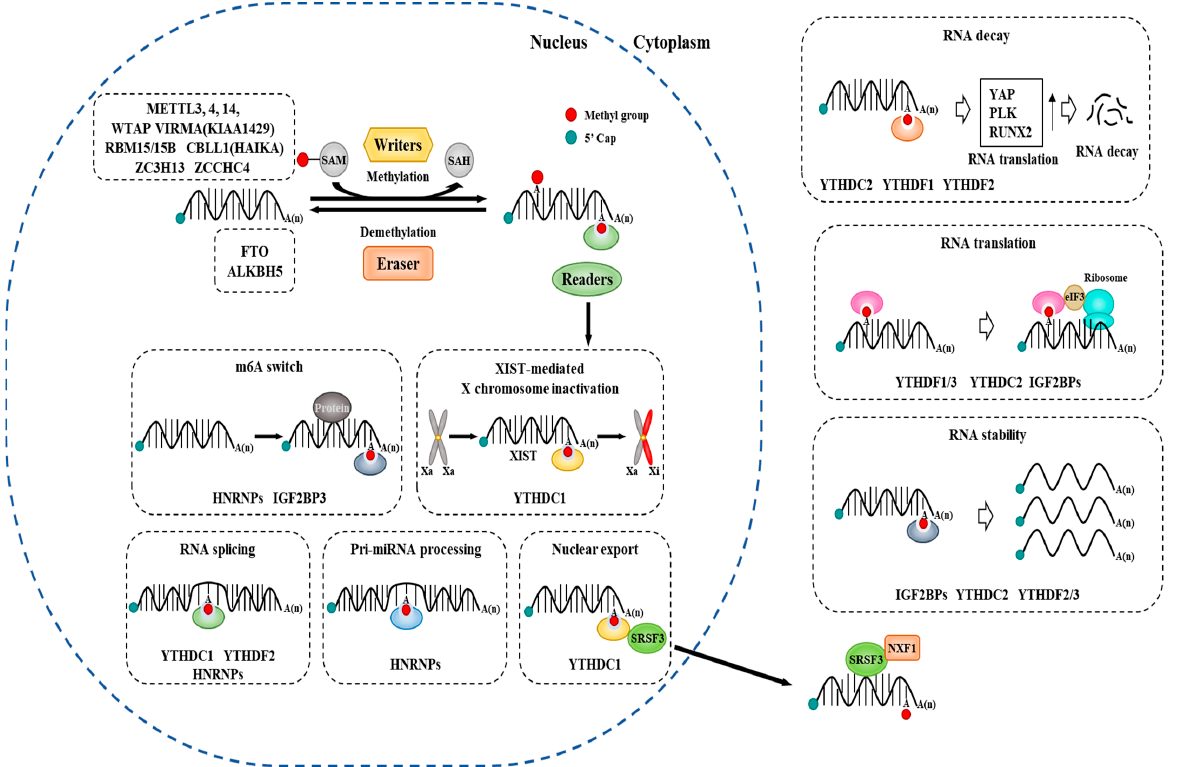
Figure 1. m6A RNA modification system. m6A methylation is catalyzed by writers, such as METTL3, METTL4, METTL5, METTL14, METTL16, WTAP, VIRMA, and others. Erasers, such as, FTO and ALKBH5, remove methyl groups on RNA. m6A binding proteins include YTHDF1-3, YTHDC1-2, HNRNPs, IGF2BP3, and others. m6A writers, erasers, and m6A binding proteins play critical roles in RNA metabolism, including RNA splicing, miRNA processing, m6A switch, RNA export, RNA decay, RNA stability, and RNA translation. Black arrows denote the direction of reaction. Table 1. Roles of m6A regulators in RNA